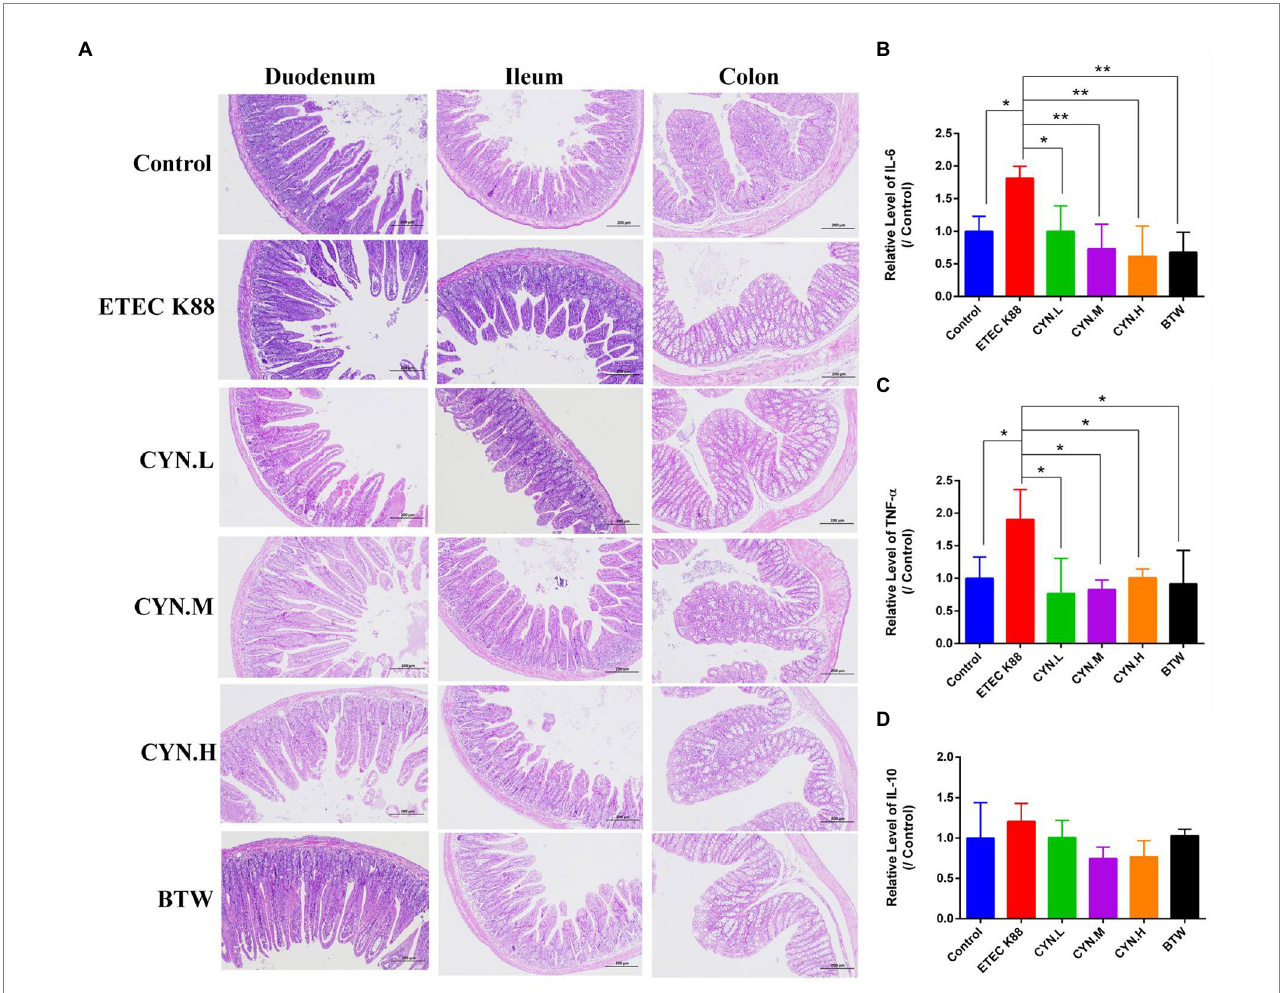
FIGURE 2 The effect of CYN on intestinal injury and inflammation of mices infected by ETEC K88. (A) The HE staining of the duodenum, ilem, colon tissues. (B) The changes of IL-6 content in each group. (C) The changes of TNF- α content in each group. (D) The changes of IL-10 content in each group. * p < 0.05, ** p < 0.01, n = 3. The H&E stained sections presented at × 100 original